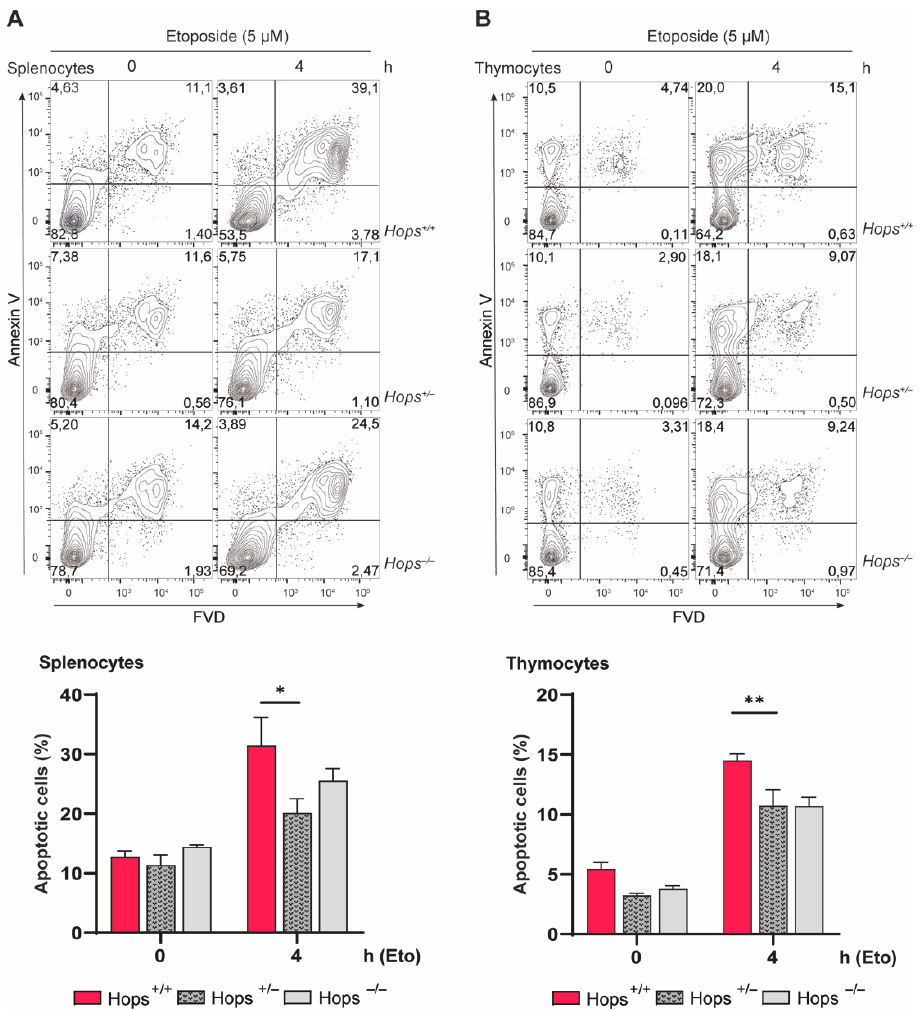
Figure 3. Apoptosis induction in heterozygous mice. ( A ) Splenocytes and ( B ) thymocytes from Hops +/+ , Hops +/ − , and Hops − / − mice were co-cultured with etoposide at 5 µ M for 4 h, and apoptosis was analyzed by flow cytometry. Representative cytofluorimetric dot plots (upper panels) and relative histograms of percent expression (lower panels) were represented. Data represent mean ± SEM and were analyzed using two-way ANOVA with Tukey's multiple-comparisons test. * p < 0.05, ** p < 0.01.